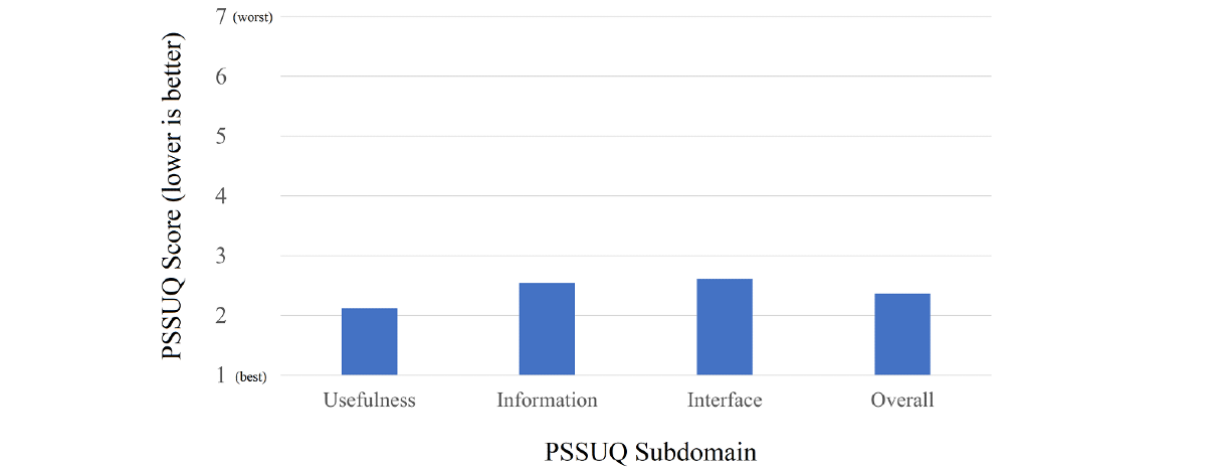
Figure 3. Bar chart of PSSUQ subdomain and total score. PSSUQ - Post-Study System Usability